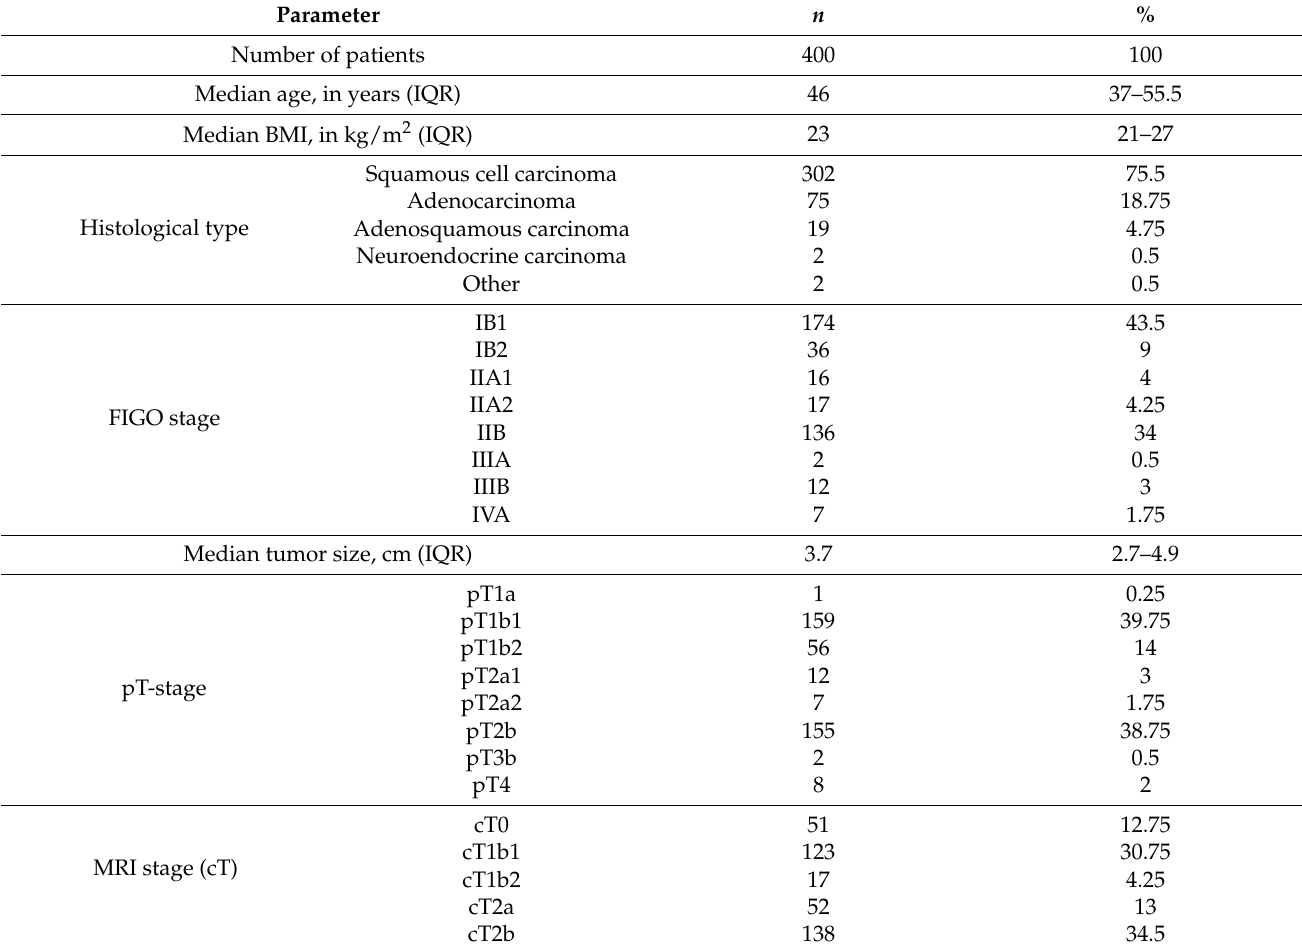
Figure 1. Flowchart depicting the patient selection process. Table 1. Patient and tumor characteristics.